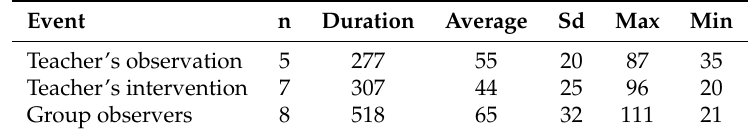
Table 1. Number and duration of events registered by the teacher and observers.